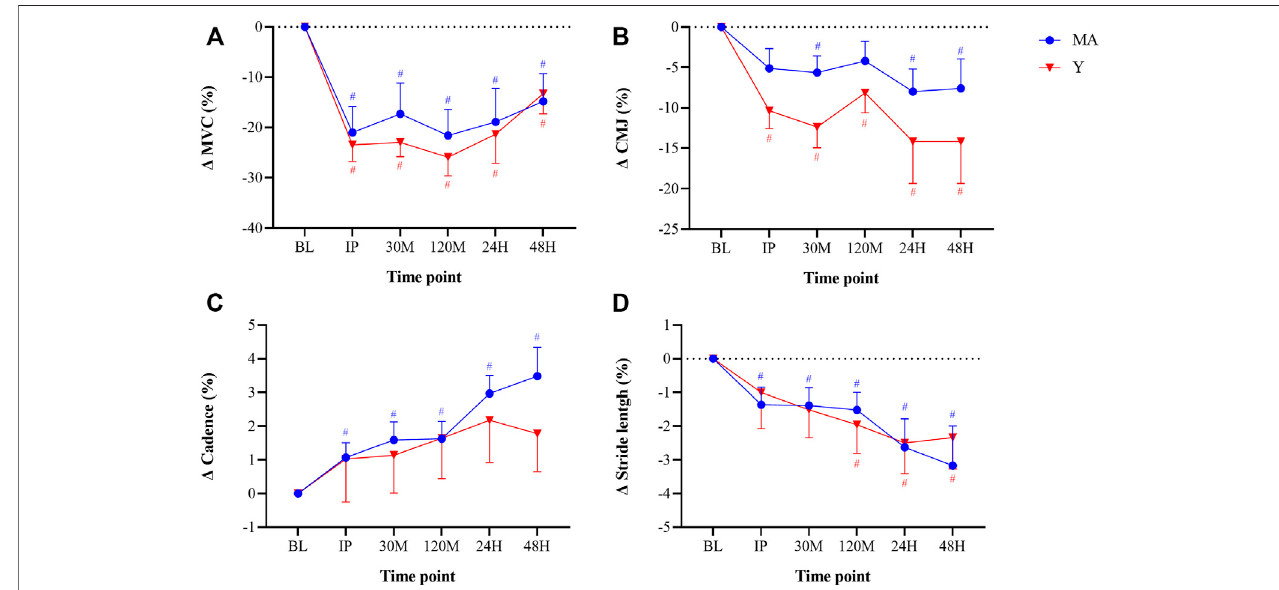
FIGURE3| Changesinmaximalvoluntarycontraction[MVC;panel (A) ],countermovementjump[CMJ;panel (B) ],cadence[panel (C) ],andstridelength[panel (D) ] relative to baseline (BL). Cadence and stride length were recorded while running at a constant pace of 9 km/h. Measurements were taken as BL, immediately post (IP), 30min(30 M),120 min(120 M),24 h(24H)and48 h(48H)followinga60 mindownhillrunningprotocol.Young(Y;redtriangle)andmiddle-age(MA;bluecircles)groups. Dotted horizontal line represents no change compared to BL. # Signi fi cant ( p < 0.05) difference compared with BL within each group. All data are reported as mean ± SEM.